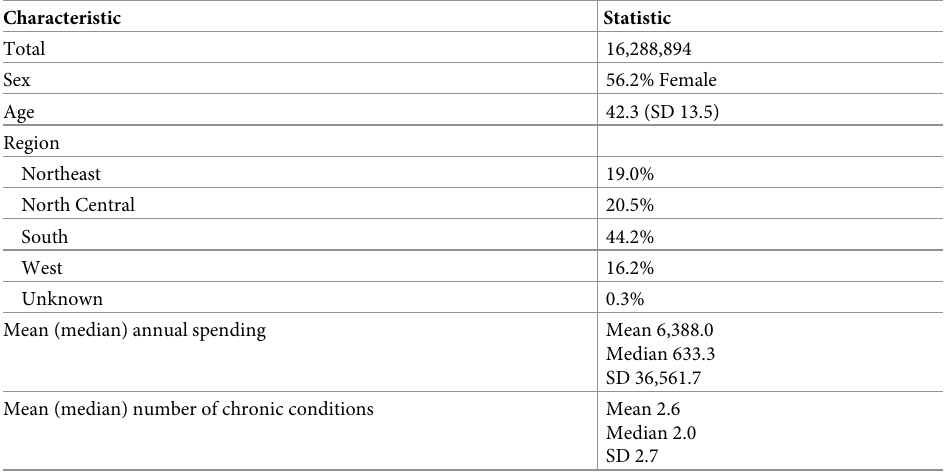
Table 2. Summary statistics of study